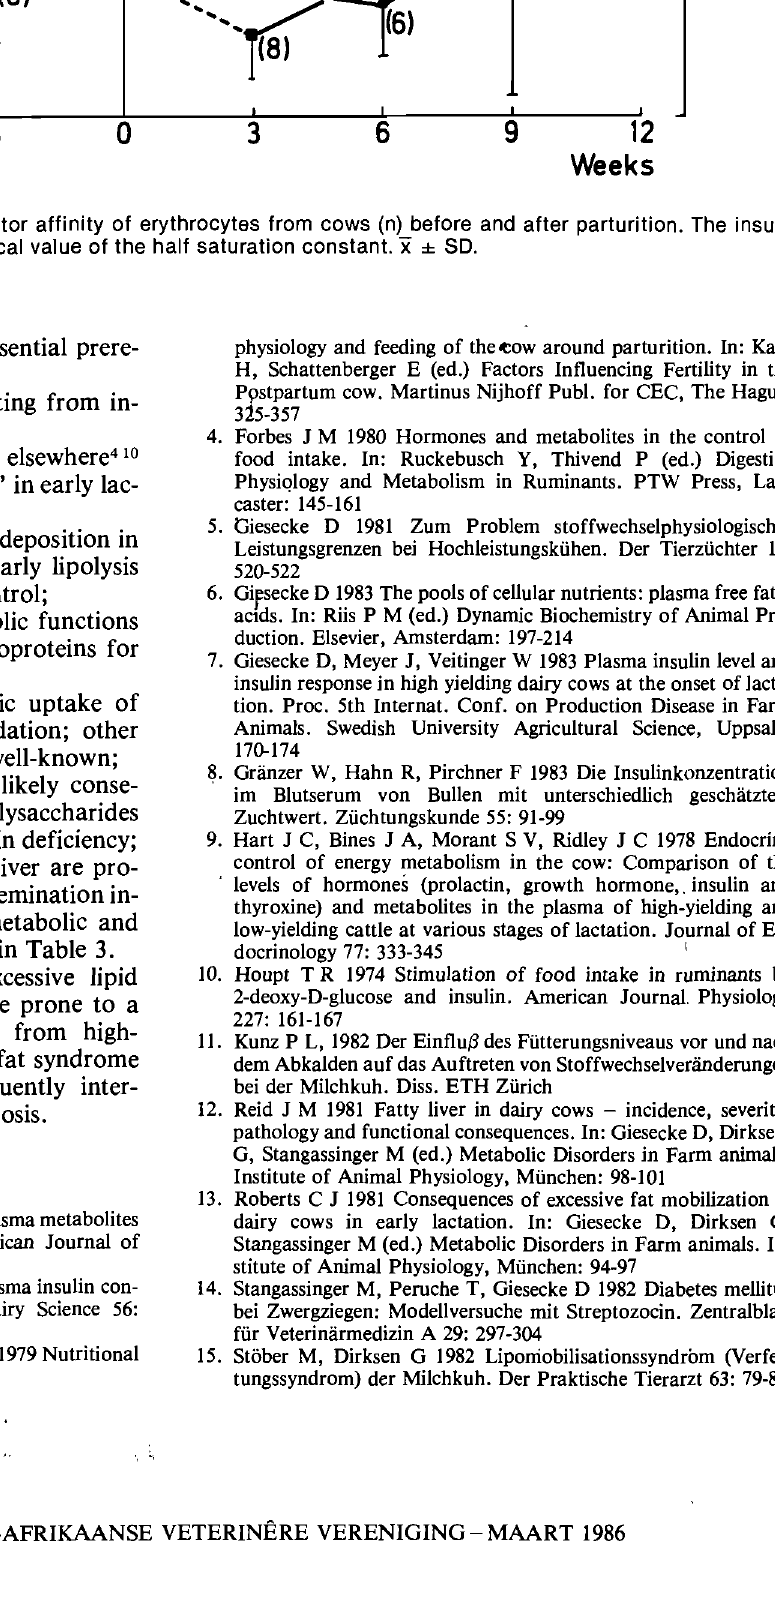
Fig. 4: Plasma insulin levels and insulin receptor affinity of erythrocytes from cows (n) before and after parturition. The insulin receptor affinity is giv'en as the reciprocal value of the half saturation constant. x ± SD.